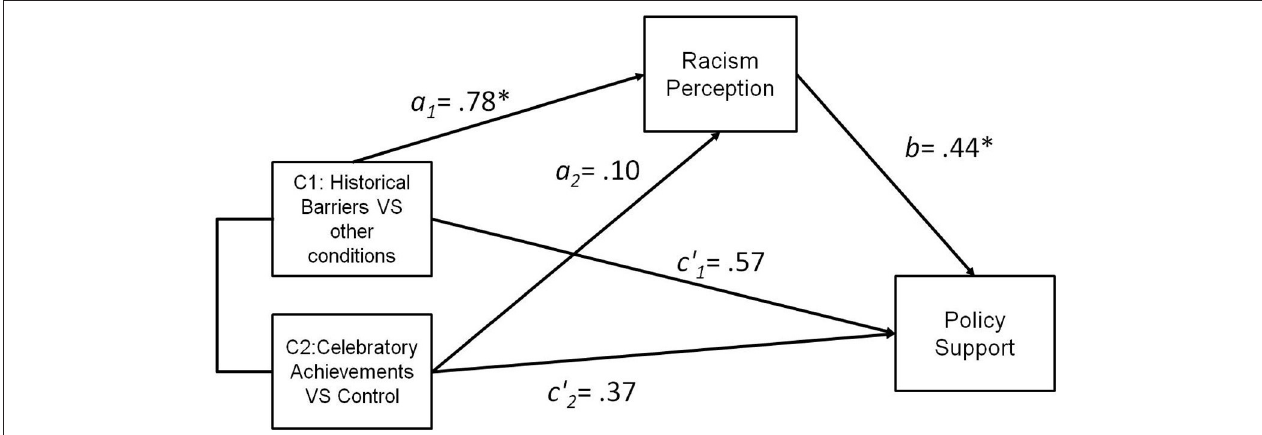
FIGURE 9 | Multicategorical mediation model of the effect of Black History Month facts on policy support via racism perception, Study 4. Indirect effect 95% Confidence Interval [0.0307; 0.9485]. C1, contrast 1; C2, contrast 2; * p < 0.05.